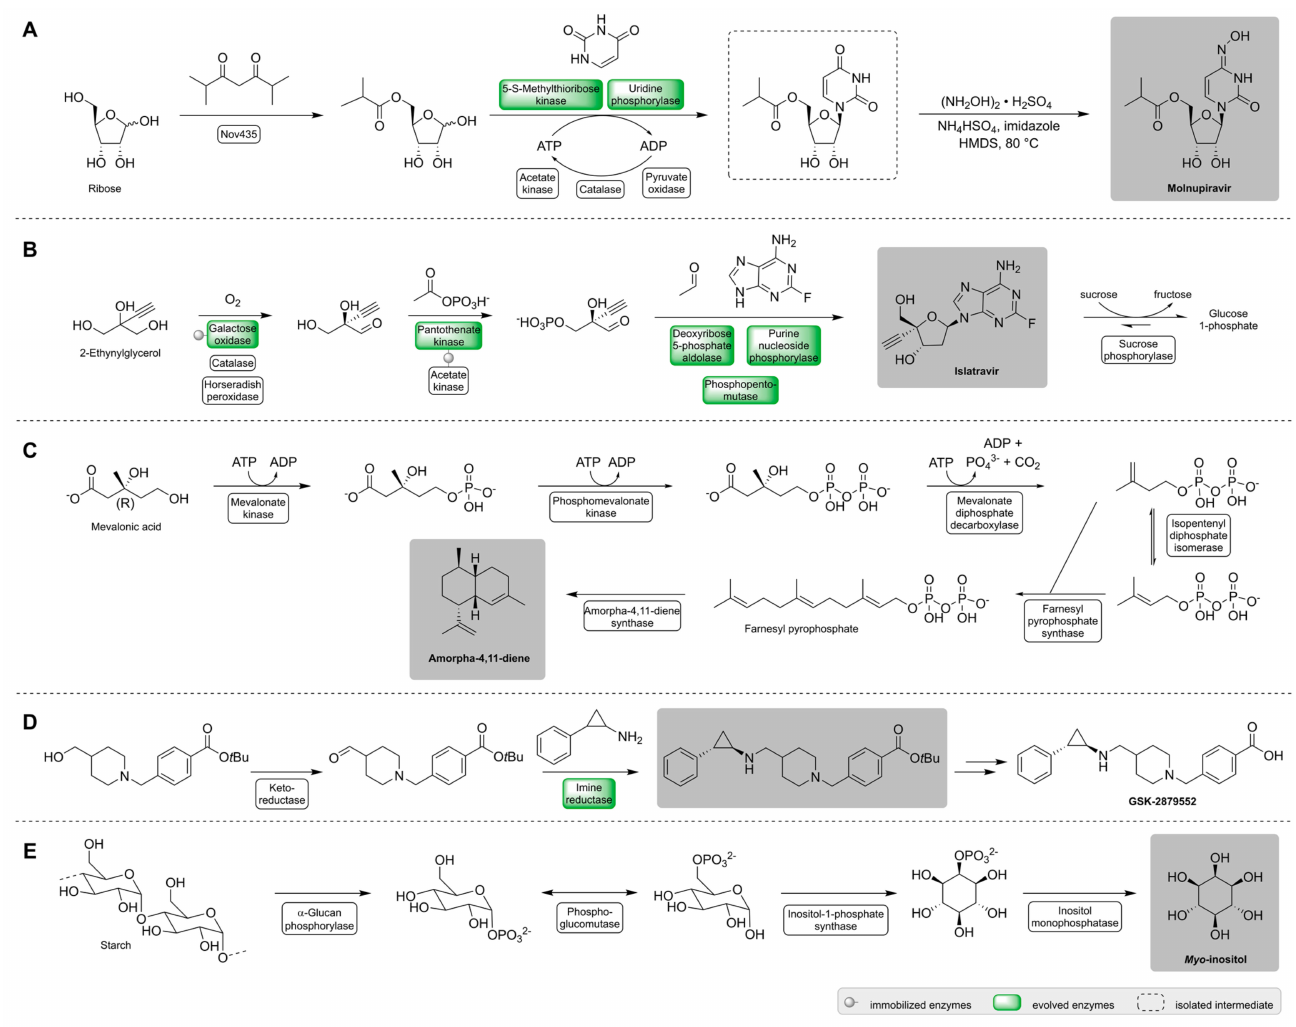
Figure 1. Enzyme cascades for the synthesis of molnupiravir ( A ) [12], islatravir ( B ) [14], artemisinin- precursor amorpha-4,11-diene ( C ) [16], protected GSK-2879552 ( D ) [19], and myo -inositol ( E )